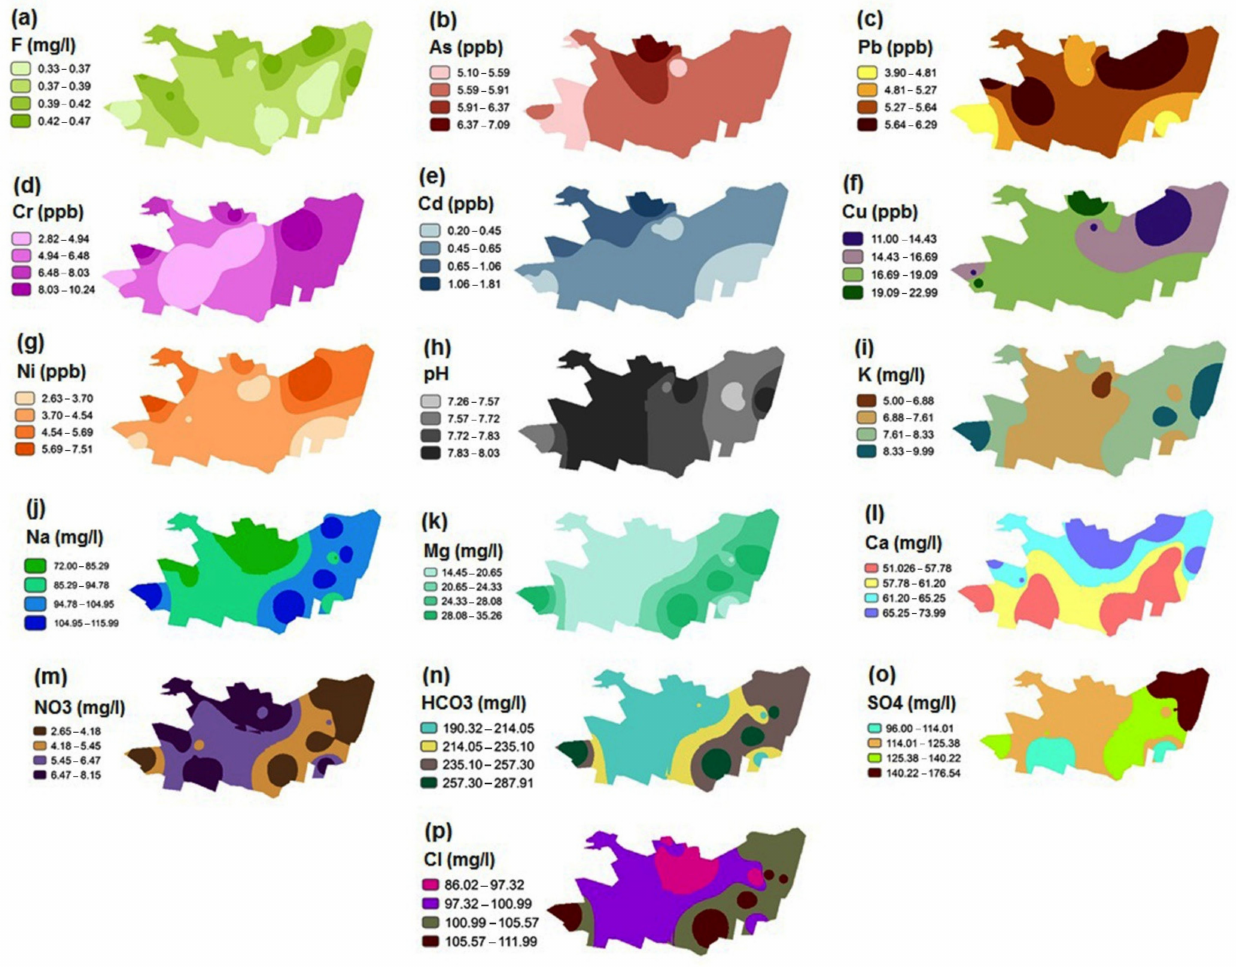
Figure 2. Spatial distribution maps of the various hydrochemical parameters in the study area. ( a ) Fluoride; ( b ) arsenic; ( c ) lead; ( d ) chromium; ( e ) cadmium; ( f ) copper; ( g ) nickel; ( h ) pH; ( i ) potassium; ( j ) sodium; ( k ) magnesium; ( l ) calcium; ( m ) nitrate; ( n ) bicarbonate; ( o ) sulphate; ( p )